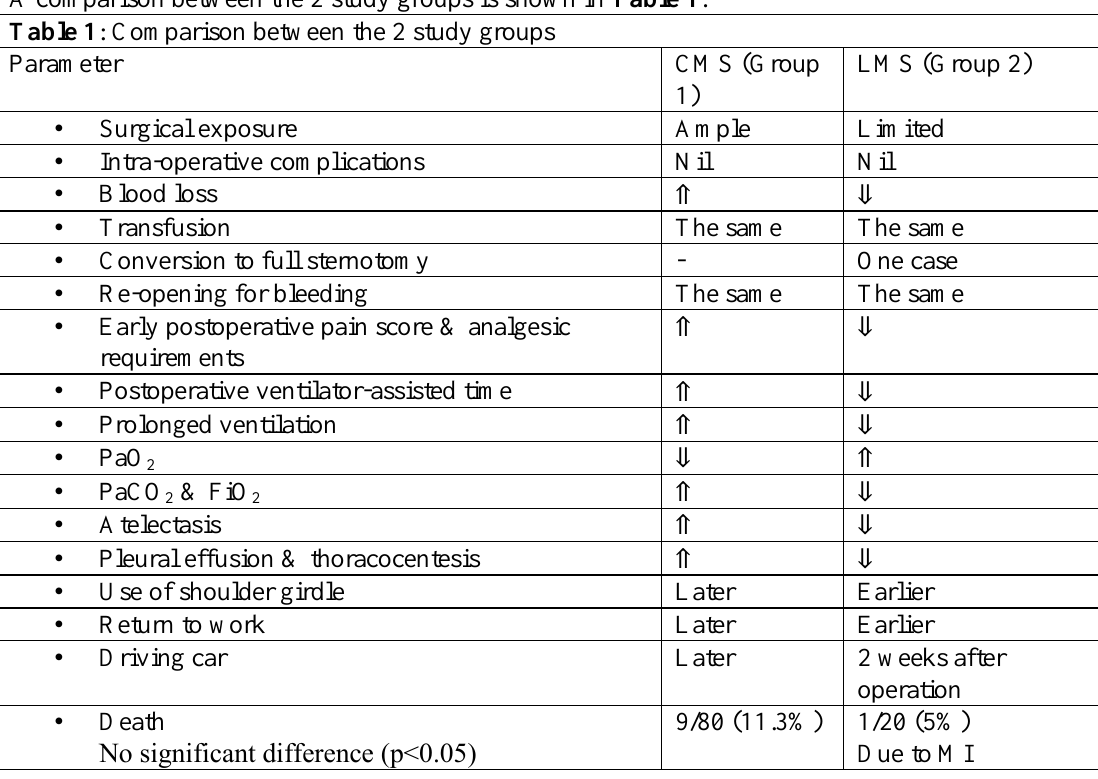
Table 1 : Comparison between the 2 study groups